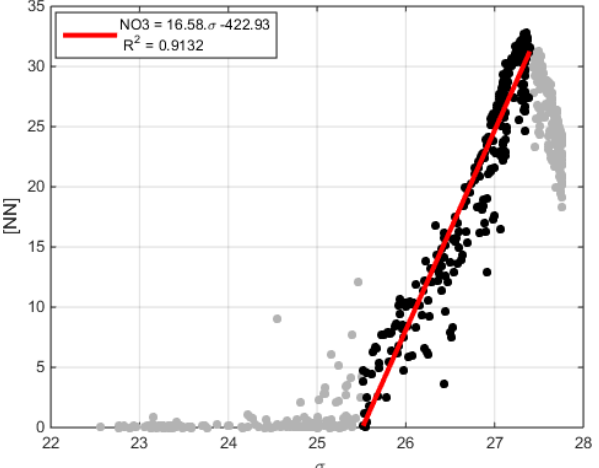
Figure 7. Basin-scale, monthly climatological mean and standard deviation of: (a) the nitracline depth, (b) the nitracline steepness. Red (blue) shows statistics for all profiles in anticyclonic (cyclonic)